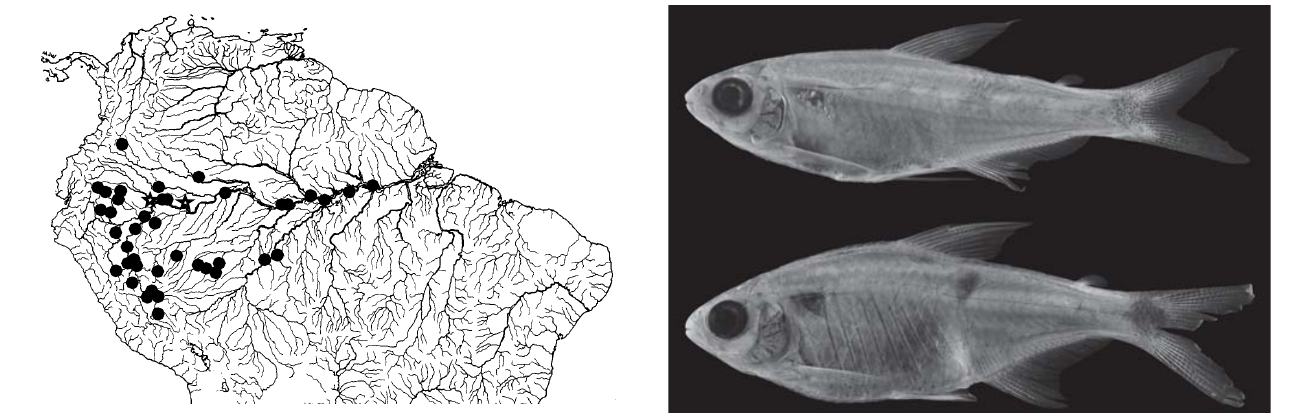
Fig. 6. Distribution of Odontostilbe fugitiva in central and northen South America. Circles (material examined, symbols can represent more than one lot, and more than one locality), and stars (type locality of neotype on the rigth and of the lost holotype on the left).